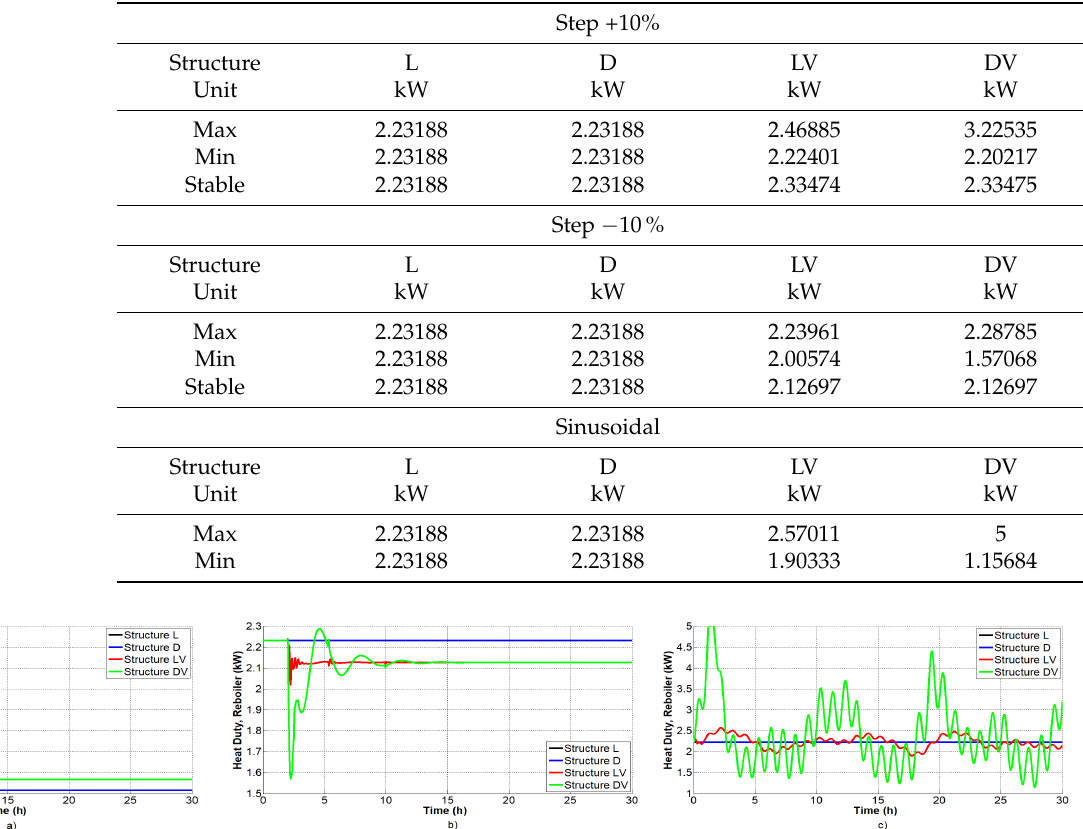
Table 11. Energy consumption of the reboiler when using control structures. Reboiler energy consumption user the control structure. Maximum, minimum, and stabilization values in the event of disturbances in the feed composition.